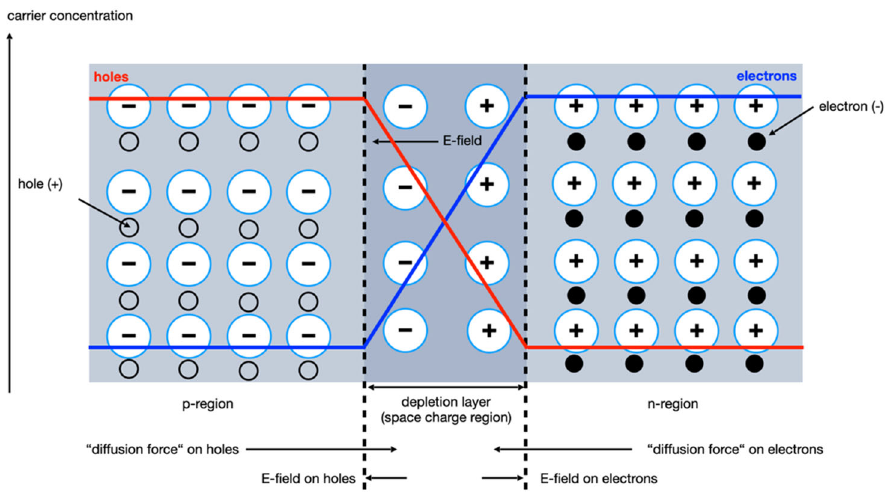
Figure 3. Schematic sketch of a p ‐ n junction.